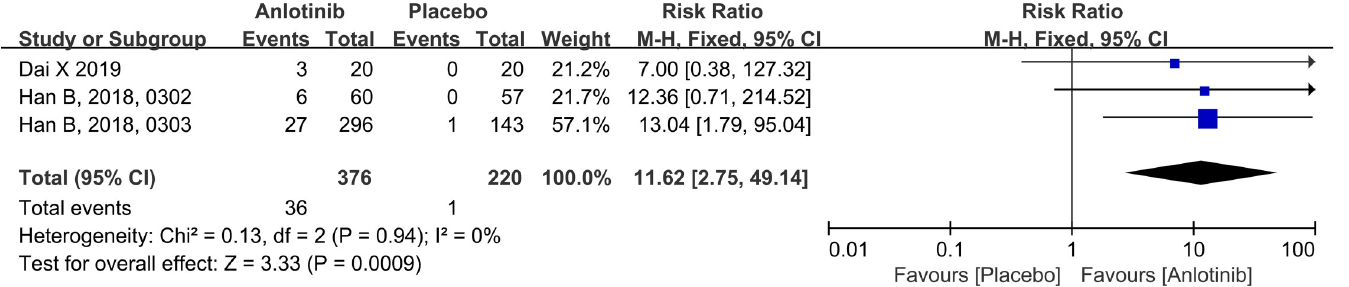
PLOS ONE | https://doi.org/10.1371/journal.pone.0242982 November30,